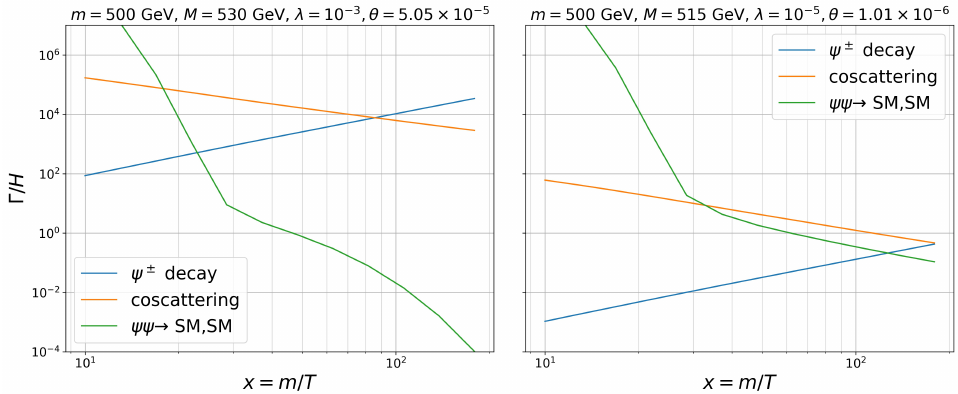
Figure 4: Contributions to the DM equilibrium for λ = 10 − 3 (left) and λ = 10 − 5 (right). Different contributions are all converted into reaction rates Γ to the universe expansion rate H ; the χ mass parameter is set to m = 500 GeV, while M is adjusted to obtain Ω h 2 ≃